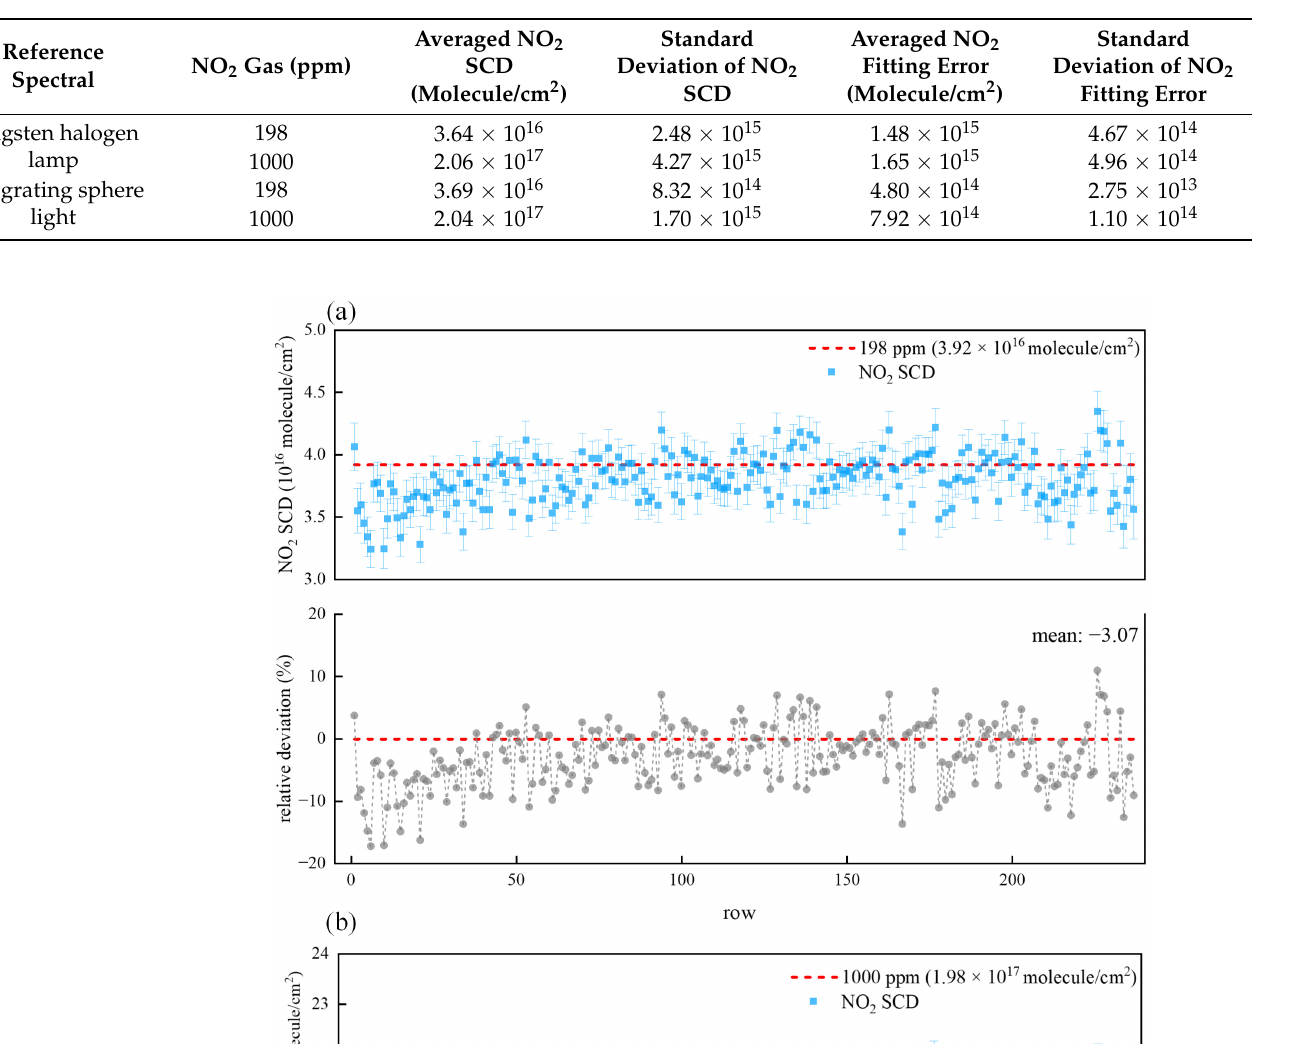
Table 4. NO 2 gas cell measurement results of limb module.